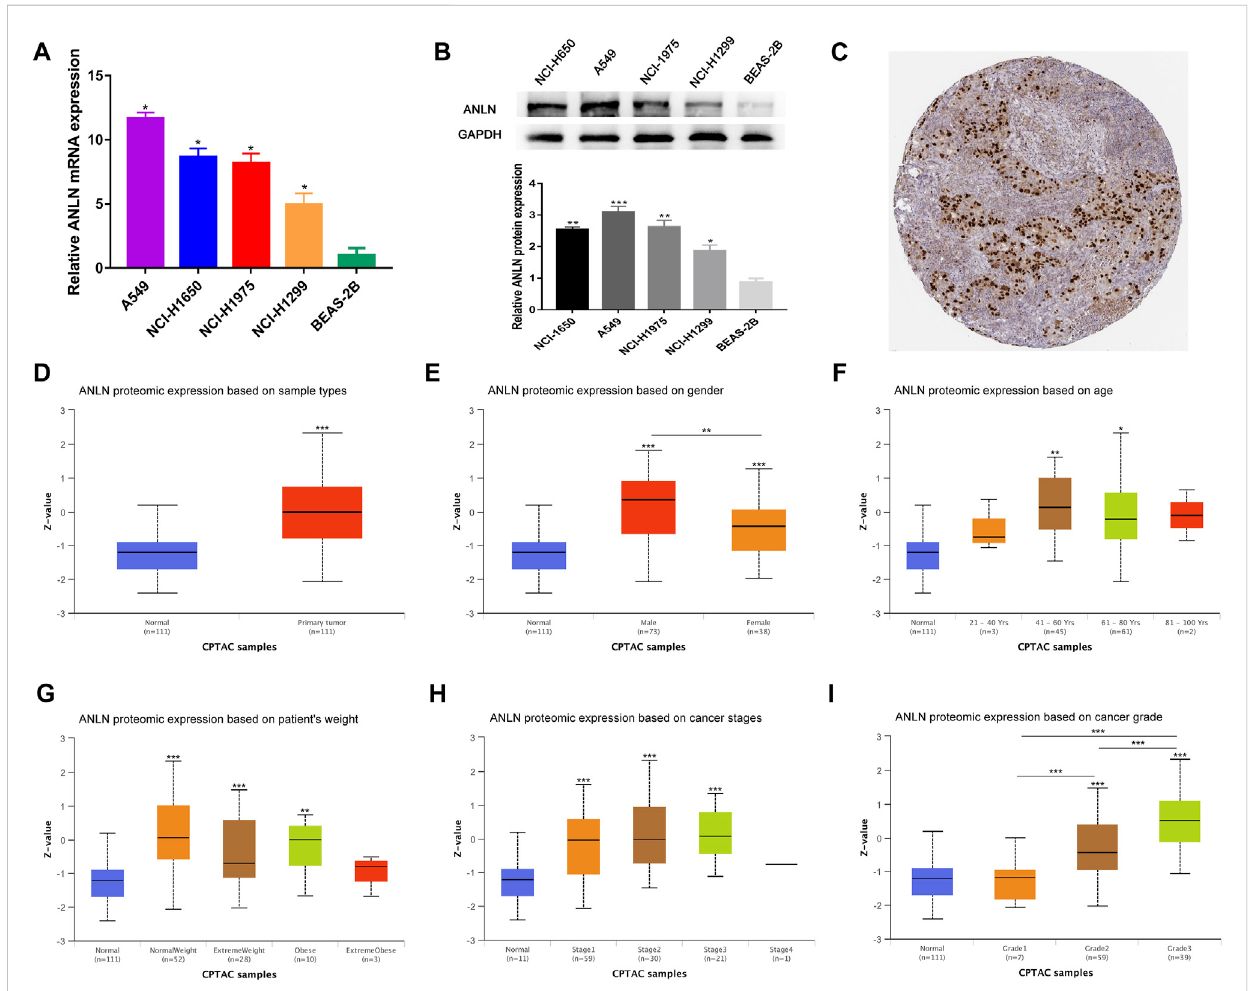
FIGURE 9 Validation of ANLN mRNA and protein expression and its association with different clinicopathological parameters in NSCLC patients. (A) qRT-PCR analysis of ANLN in four NSCLC cell lines and normal lung epithelial cell line. (B) Western blotting of ANLN in four NSCLC cell lines and normal lung epithelialcellline. (C) ImmunohistochemicalresultofANLNinlungcancertissuesinHPAdatabase. (D – I) Diverseclinicopathologicalparameters:Sample types, patients ’ gender, age, weight, pathologic stage and tumor grade. * p < 0.05, ** p < 0.01, *** p < 0.001. NSCLC, non-small cell lung